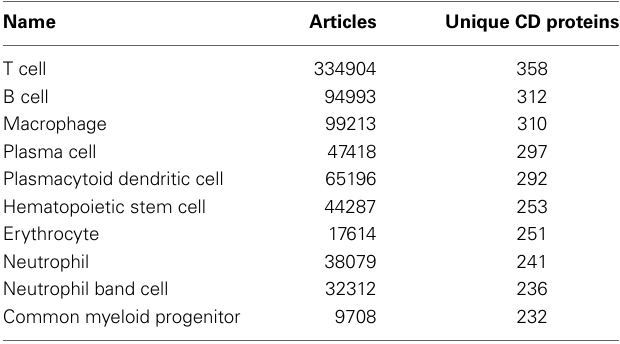
Table 2 | Ten least characterized cell types, as judged by available CD molecule data in the primary